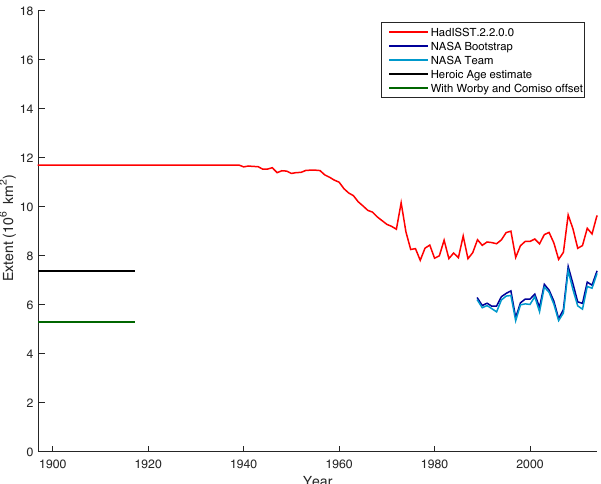
Figure 4. The estimated DJFM Antarctic sea ice extent climatology for the period 1897–1917, with and without the inclusion of the Worby and Comiso offset, is plotted alongside time series of DJFM mean sea ice extent calculated from HadISST2.2, NASA Team and NASA PM Bootstrap sea ice concentration